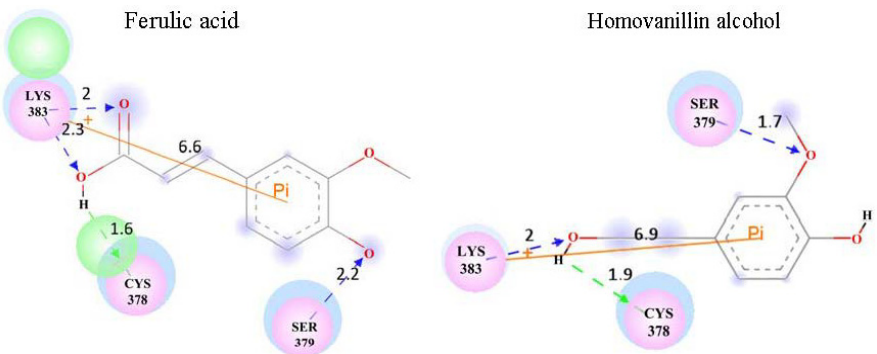
Figure 3. The key interactions between predicted good inhibitors and